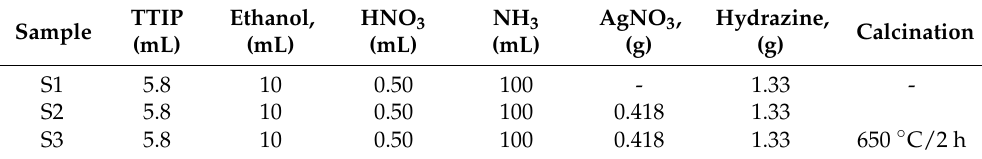
Table 1. Experimental conditions for obtaining the